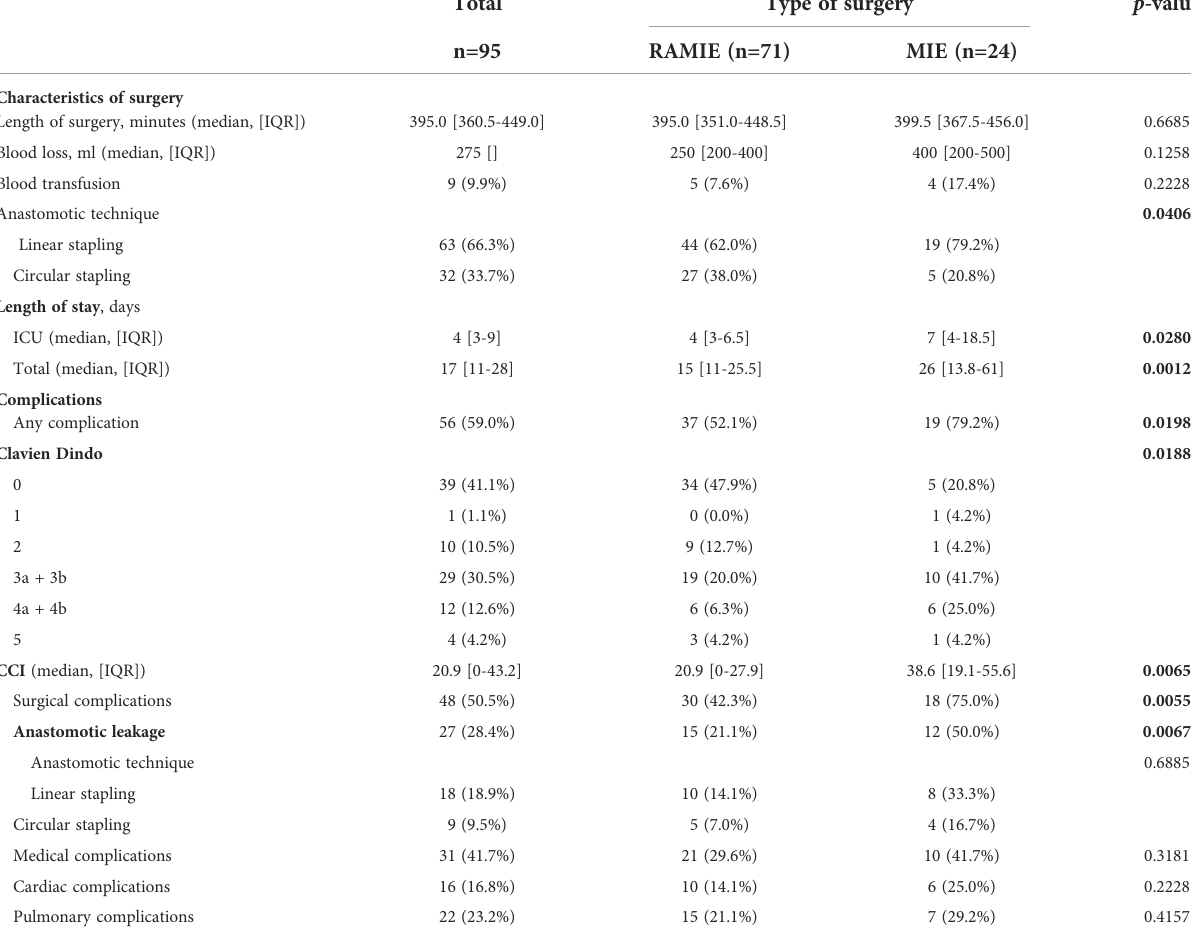
TABLE 3 Perioperative